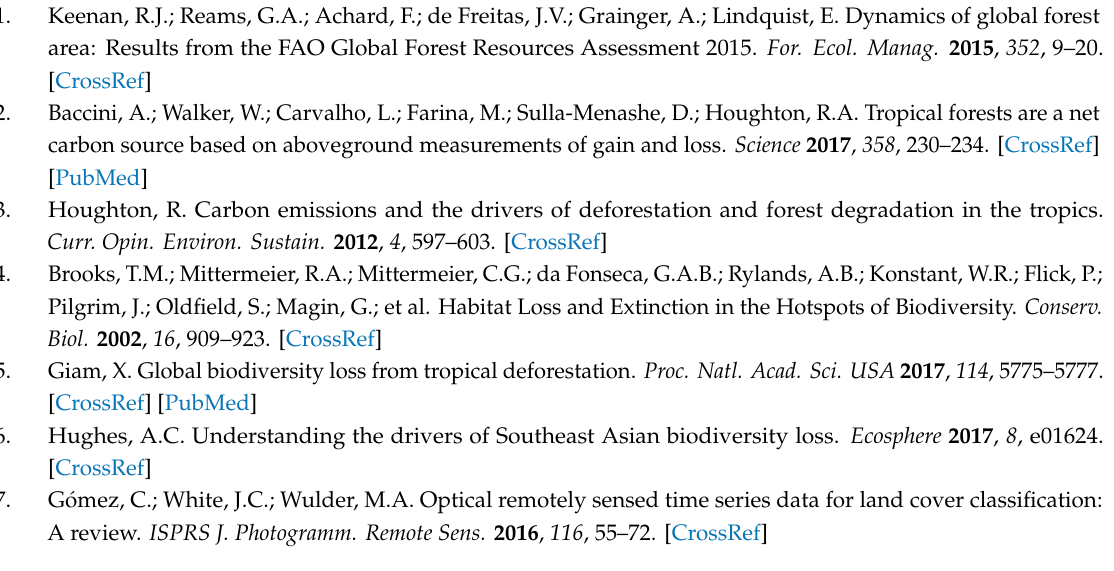
Figure S1: Forest cover maps in 2016 using tree cover percent in one pixel and (3 × 3) pixels at 10% tree cover threshold, Figure S2: Forest cover maps in 2016 using tree cover percent in one pixel and (3 × 3) pixels at 20% tree cover threshold, Figure S3: Forest cover maps in 2016 using tree cover percent in one pixel and (3 × 3) pixels at 30% tree cover threshold, Figure S4: Forest cover maps in 2016 using tree cover percent in one pixel and (3 × 3) pixels at 40% tree cover threshold, Figure S5: Forest cover maps in 2016 using tree cover percent in one pixel and (3 × 3) pixels at 50% tree cover threshold, Figure S6: Forest cover maps in 2016 using tree cover percent in one pixel and (3 × 3) pixels at 60% tree cover threshold, Figure S7: Forest cover maps in 2016 using tree cover percent in one pixel and (3 × 3) pixels at 70% tree cover threshold, Figure S8: Forest cover maps in 2016 using tree cover percent in one pixel and (3 × 3) pixels at 80% tree cover threshold, Figure S9: Forest cover maps in 2016 using tree cover percent in one pixel and (3 × 3) pixels at 90% tree cover threshold, Table S1: Accuracies of forest cover maps in 2016 using one pixel and (3 × 3) pixels at 10% tree cover threshold, Table S2: Accuracies of forest cover maps in 2016 using one pixel and (3 × 3) pixels at 20% tree cover threshold, Table S3: Accuracies of forest cover maps in 2016 using one pixel and (3 × 3) pixels at 30% tree cover threshold, Table S4: Accuracies of forest cover maps in 2016 using one pixel and (3 × 3) pixels at 40% tree cover threshold, Table S5: Accuracies of forest cover maps in 2016 using one pixel and (3 × 3) pixels at 50% tree cover threshold, Table S6: Accuracies of forest cover maps in 2016 using one pixel and (3 × 3) pixels at 60% tree cover threshold, Table S7: Accuracies of forest cover maps in 2016 using one pixel and (3 × 3) pixels at 70% tree cover threshold, Table S8: Accuracies of forest cover maps in 2016 using one pixel and (3 × 3) pixels at 80% tree cover threshold, Table S9: Accuracies of forest cover maps in 2016 using one pixel and (3 × 3) pixels at 90% tree cover